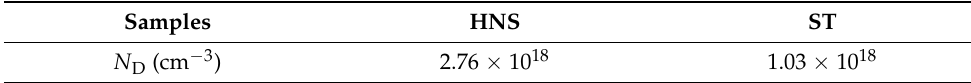
Table 3. Donor densities of passive films formed on HNS and ST.